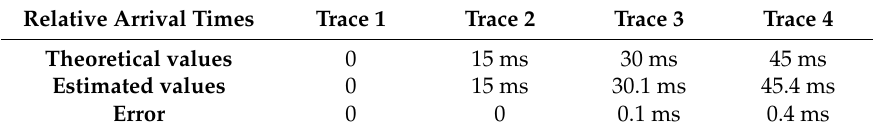
Table 3. The comparison of the theoretical values and the estimated values of the relative arrival times. Relative Arrival